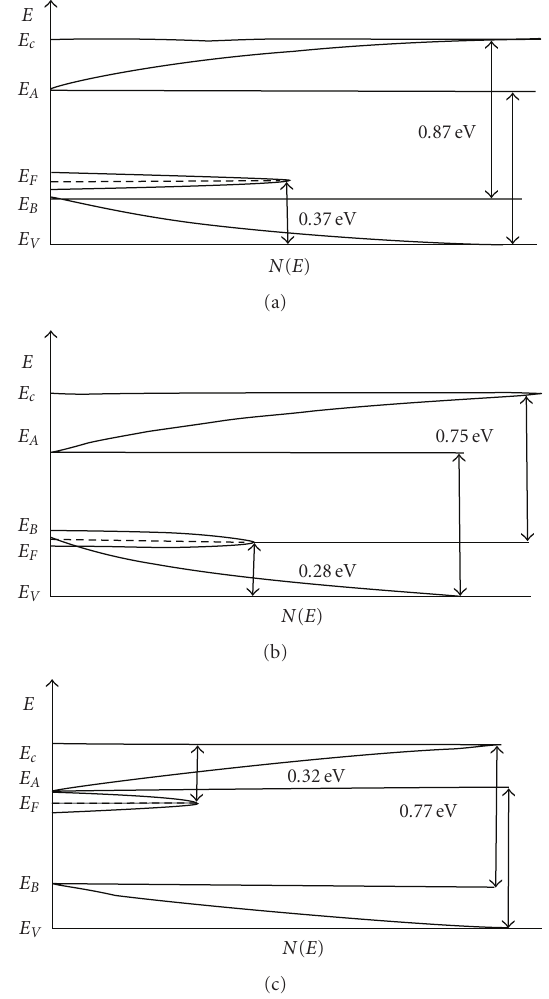
Figure 7: A proposed model of the density of states for (a) pure, (b) p-type, and (c) n-type for a-Ge 0 . 5 Si 0 . 5 :H thin